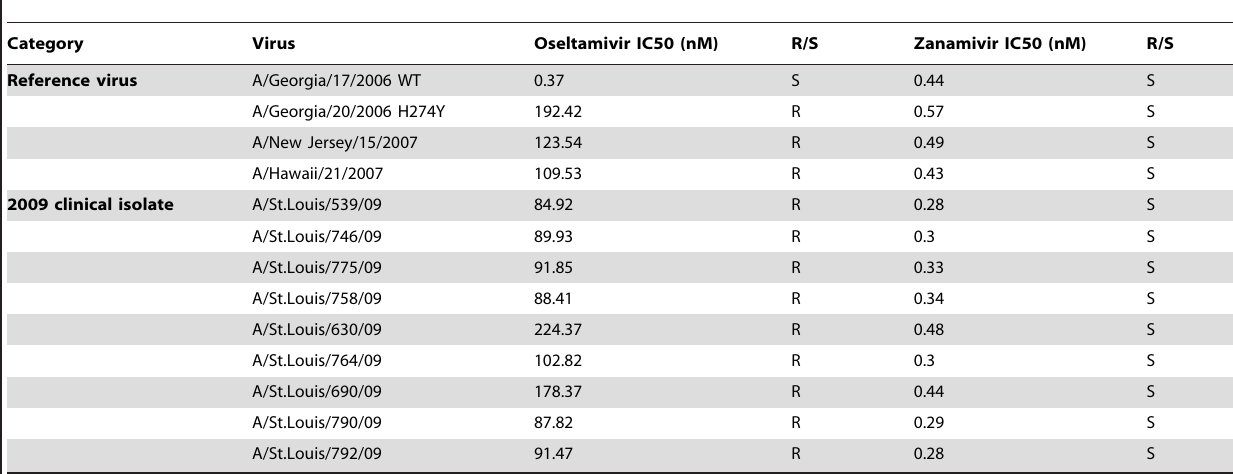
Table 2. Sensitivity of the 2009 clinical isolates to NAIs based on NA enzymatic activity.